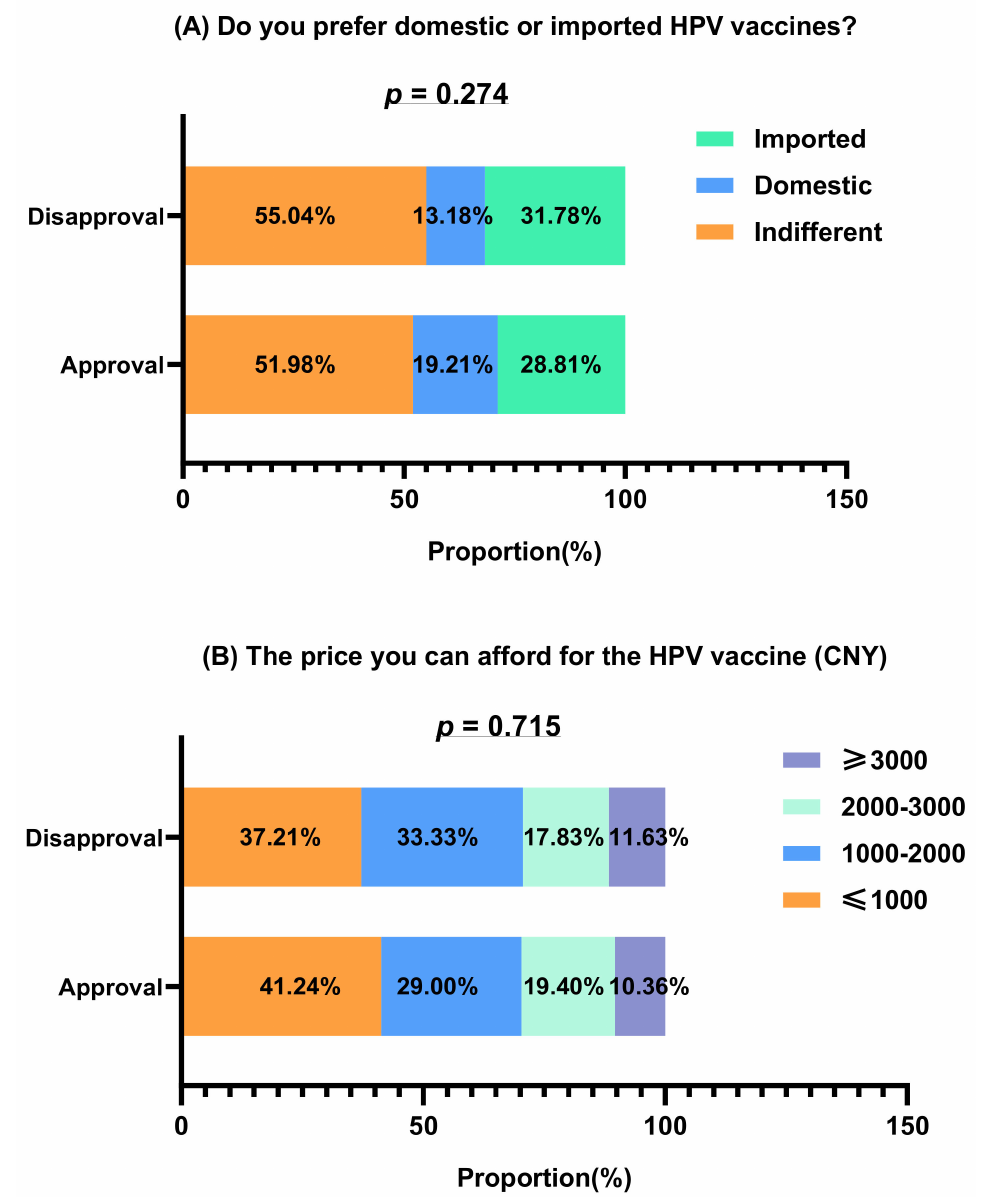
Figure 1. ( A ) Comparison of preferences for domestic or imported vaccines. ( B ) Comparison of affordable vaccine prices for participants ( n =